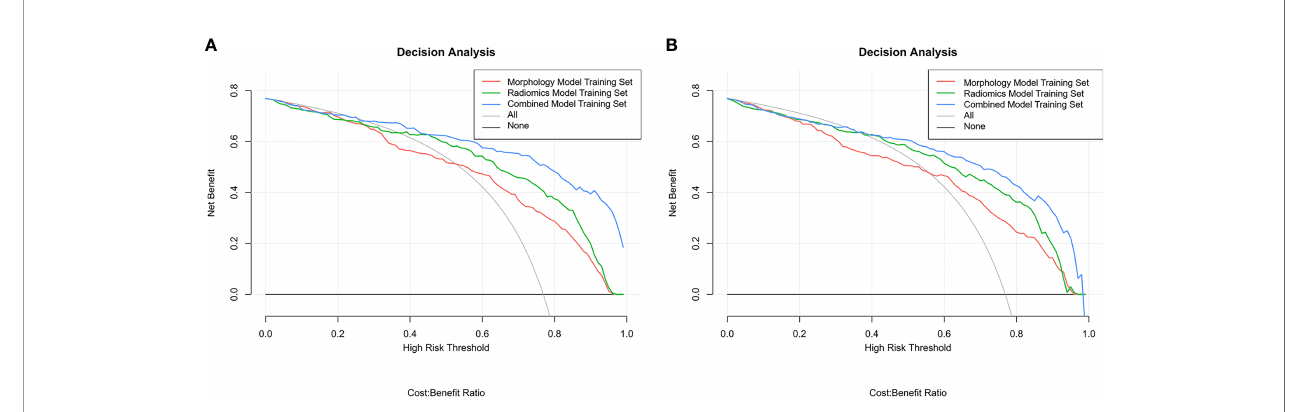
FIGURE 6 | The DCA comparison of training cohorts (A) and validation cohorts